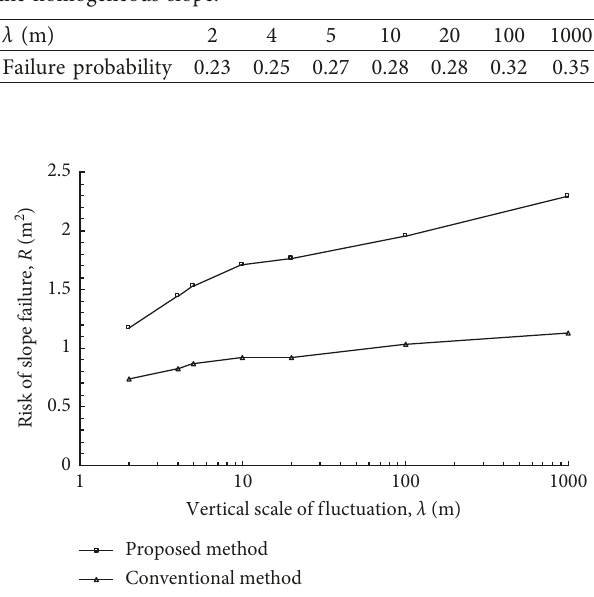
Figure 6: Effect of vertical spatial variability of friction angle on slope failure risk for homogeneous slope.